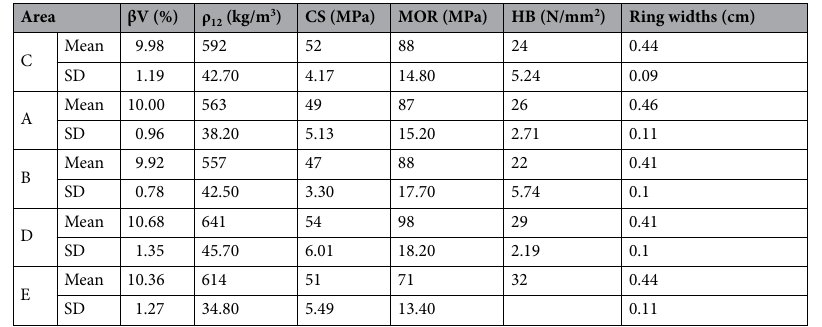
Table 2. Physical and mechanical characteristics of chestnut wood of Amiata provenance. Wood density at 12% moisture (ρ12), total volumetric shrinkage (βV), compression strength (σ12), bending strength (MOR), Brinell hardness (HB) and ring width (RW).